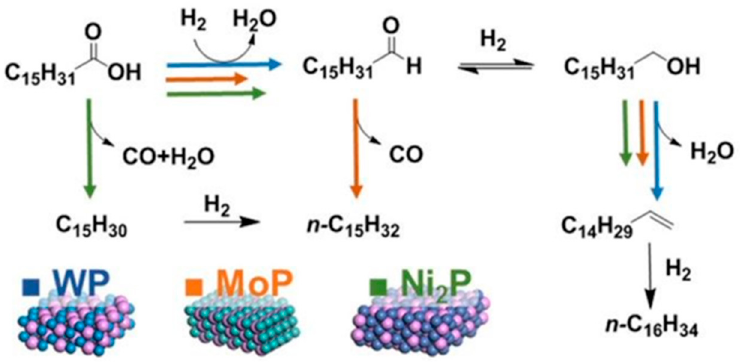
Figure 10. Different mechanistic pathways of the reaction. Reprinted with permission from Ref.